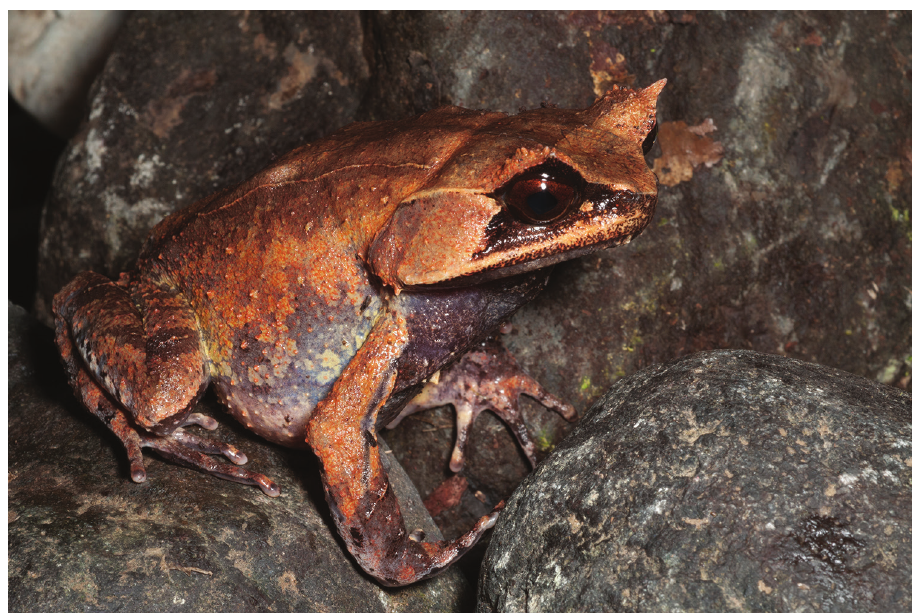
Figure 18. Megophrys stejnegeri male (KU 333289) from Mt. Lumot, Municipality of Gingoog, Misamis Oriental Province. Photo: